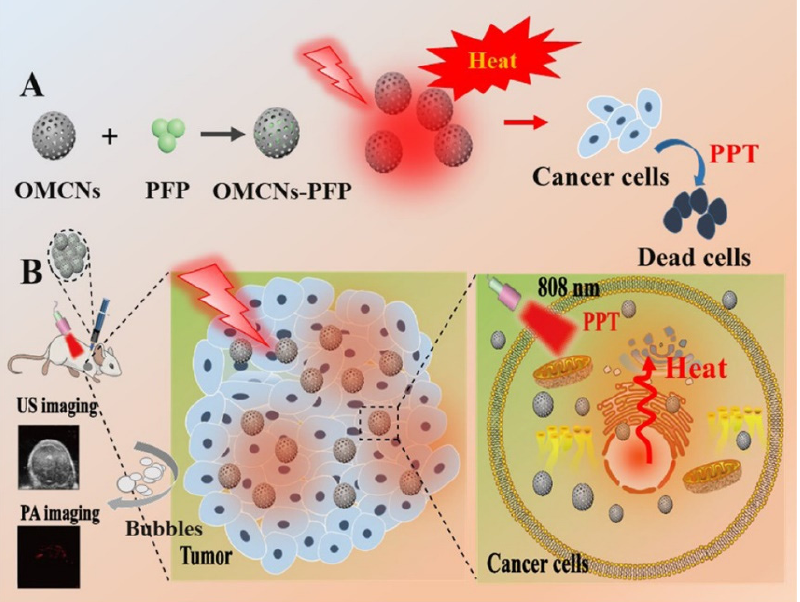
Figure 7. Schematic illustration of a phase-change nanotherapeutic agent based on mesoporous carbon ( A ) for ultrasound (US) imaging and photoacoustic (PA) imaging and tumor therapy ( B ) [105].